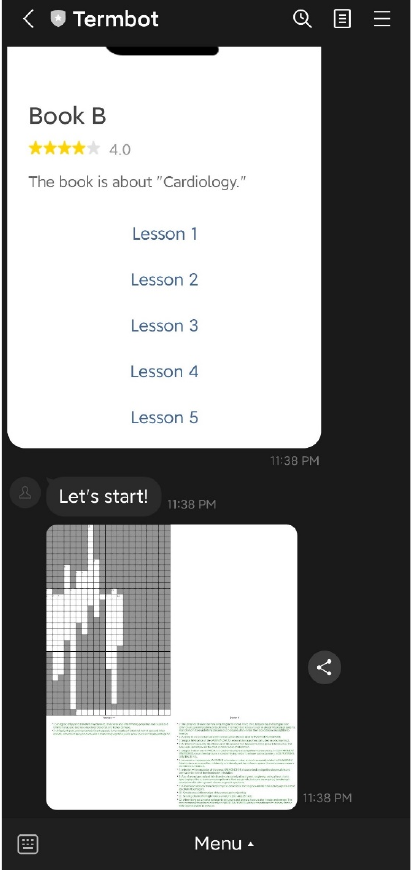
Figure 6. The puzzle is generated by the function “Practice by book or